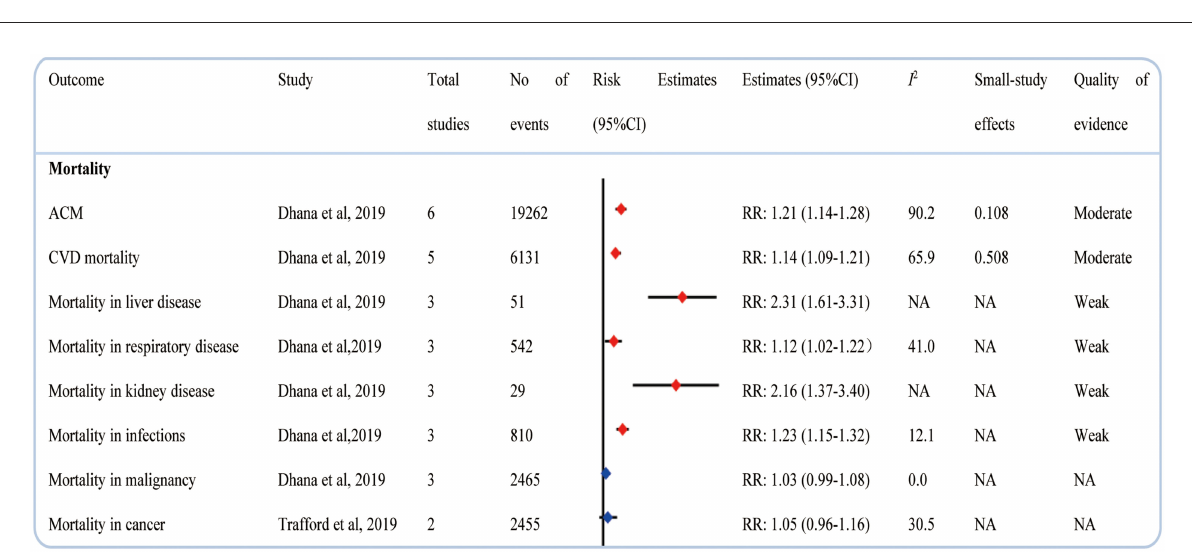
pregnancy-related outcomes such as cesarean delivery, preterm birth, (pre)eclampsia, gestational diabetes, gestational hypertension, premature of membranes, and prematurity;